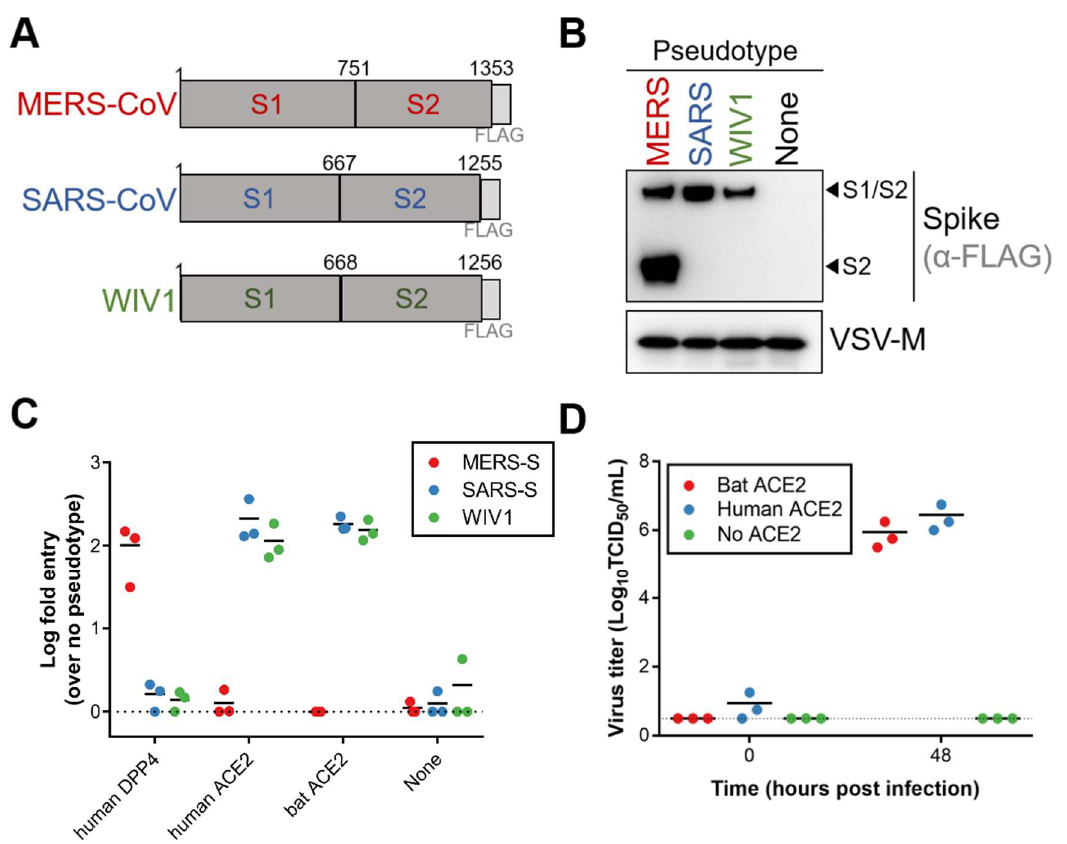
Figure 1. Egyptian fruit bat ACE2 is a suitable receptor for WIV1-CoV. ( A ) Schematic overview of coronavirus spike proteins. ( B ) VSV particles pseudotyped with coronavirus spike proteins were concentrated and analyzed for spike incorporation by Western blot. ( C ) BHK cells were transfected with coronavirus receptors and infected with pseudotyped particles in triplicate. ( D ) BHK cells were transfected with ACE2 plasmids and inoculated with WIV1-CoV at a MOI of 0.01, 24 h after transfection. Supernatants were harvested at 0, and 48 hpi and viral titers were determined by endpoint titration in quadruplicate in VeroE6 cells.